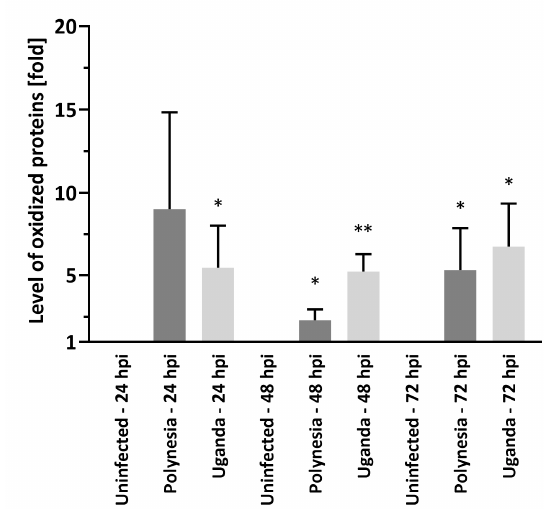
Figure 9. ZIKV infection induces elevated levels of oxidized proteins. Oxyblot analysis of lysates derived from uninfected lt-NES ® cells and lt-NES ® cells, which were infected with ZIKV Uganda and ZIKV Polynesia at MOI of 1 at 24, 48 and 72 hpi. Protein oxidation was analyzed by incubation with 2,4,-dinitrophenylhydrazine (DNPH) for covalent modification of oxidative modified proteins. Error bar represents the mean ± SEM of n = 3 biological replicates; * p < 0.05; ** p < 0.01.